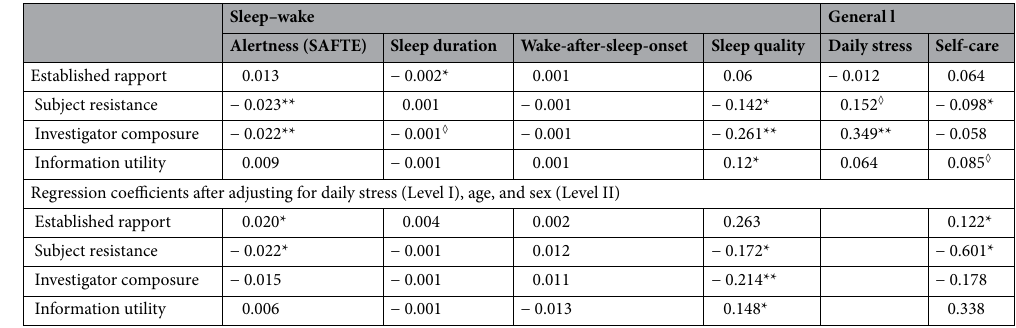
Table 4. Estimates of Fixed Effects from Individual Multi-Level Models of Daytime Functioning Variables as Day-Level Predictors of Investigative Interview Characteristics (N = 168–204 days). All continuous